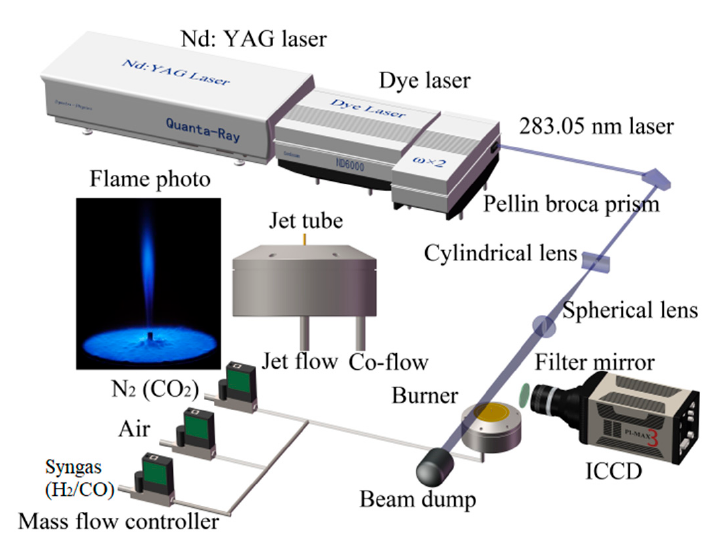
Figure 1. Schematic of experiment setup. Table 1. Operation conditions of syngas/air premixed jet